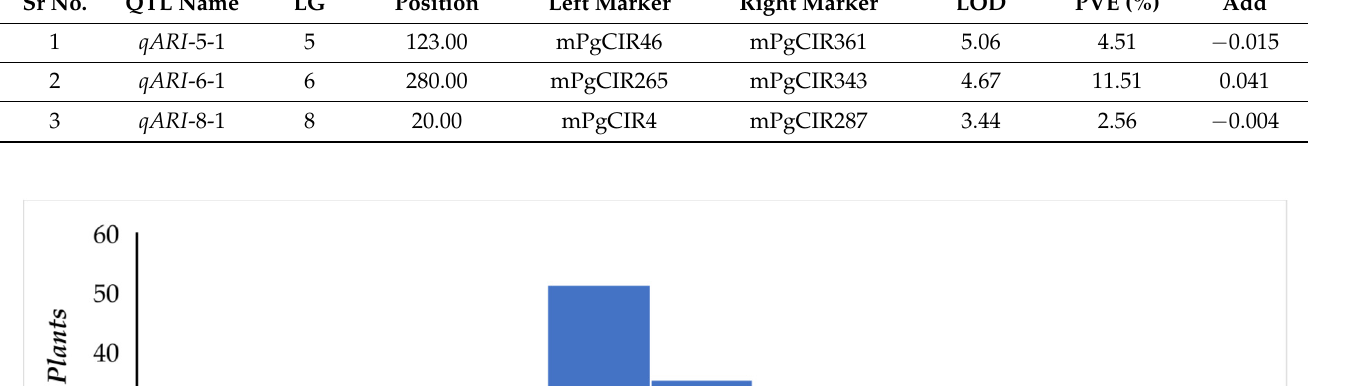
Table 2. QTL analysis for anthocyanin reflective index ( ARI 1) using CIM algorithm. Sr No.